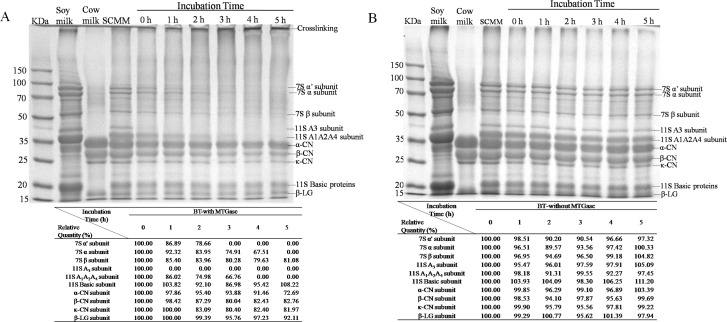
Sodium dodecyl sulfate polyacrylamide gel electrophoresis (SDS-PAGE) profiles of the soy-cow milk mixtures fermented with addition of MTGase (A) or not (B) for different periods from 0 h to 5 h. 7S α′-, 7S α- and 7S β-: subunits of β-conglycinin; 11S A3, 11S A1A2A4 and 11S Basic: acidic and basic subunits of glycinin; α-CN, β-CN and κ-CN of casein; β-LG of whey protein. Relative quantity (%) of every protein band was found within the table.